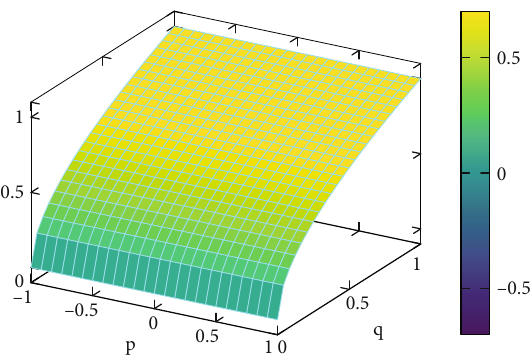
Figure 1: Wigner function for Gross-Pitaevskii model; n = 100 . Figure 2: Wigner function for Gross-Pitaevskii model; n = 200 .